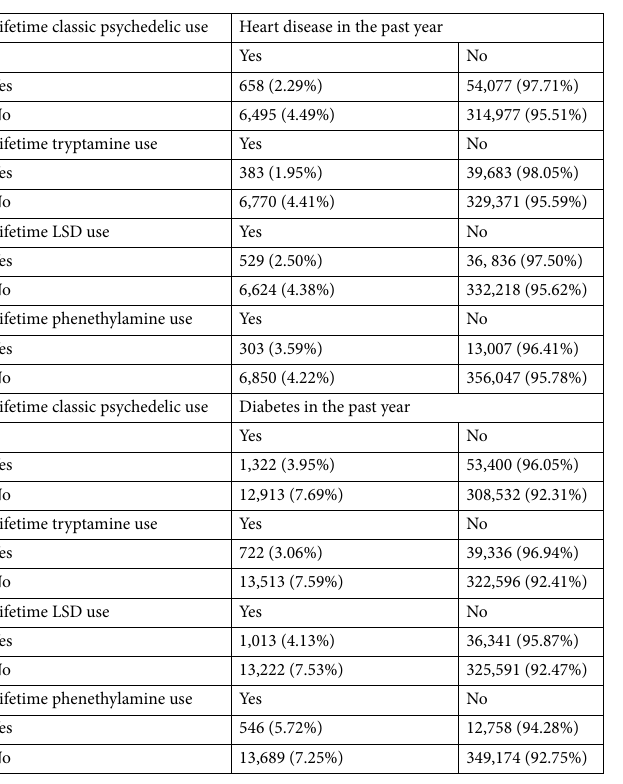
Table 1. Percentage of respondents with heart disease or diabetes in the past year. The number of observations with heart disease in the past year was 376,207; the number of observations with diabetes in the past year was 376,167. The unweighted number of respondents are presented in each cell and the weighted percentage of respondents are presented within